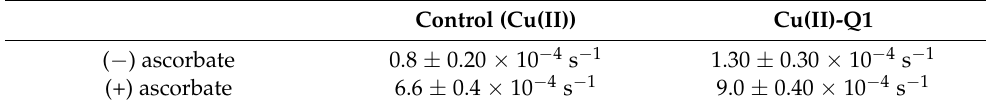
Table 3. Rate constants for the initiation reaction of LA peroxidation in micelles induced by the Q1 copper complexes relative to the control (i.e., unchelated Cu(II) added as CuCl2) in the presence and absence of ascorbate (2.5